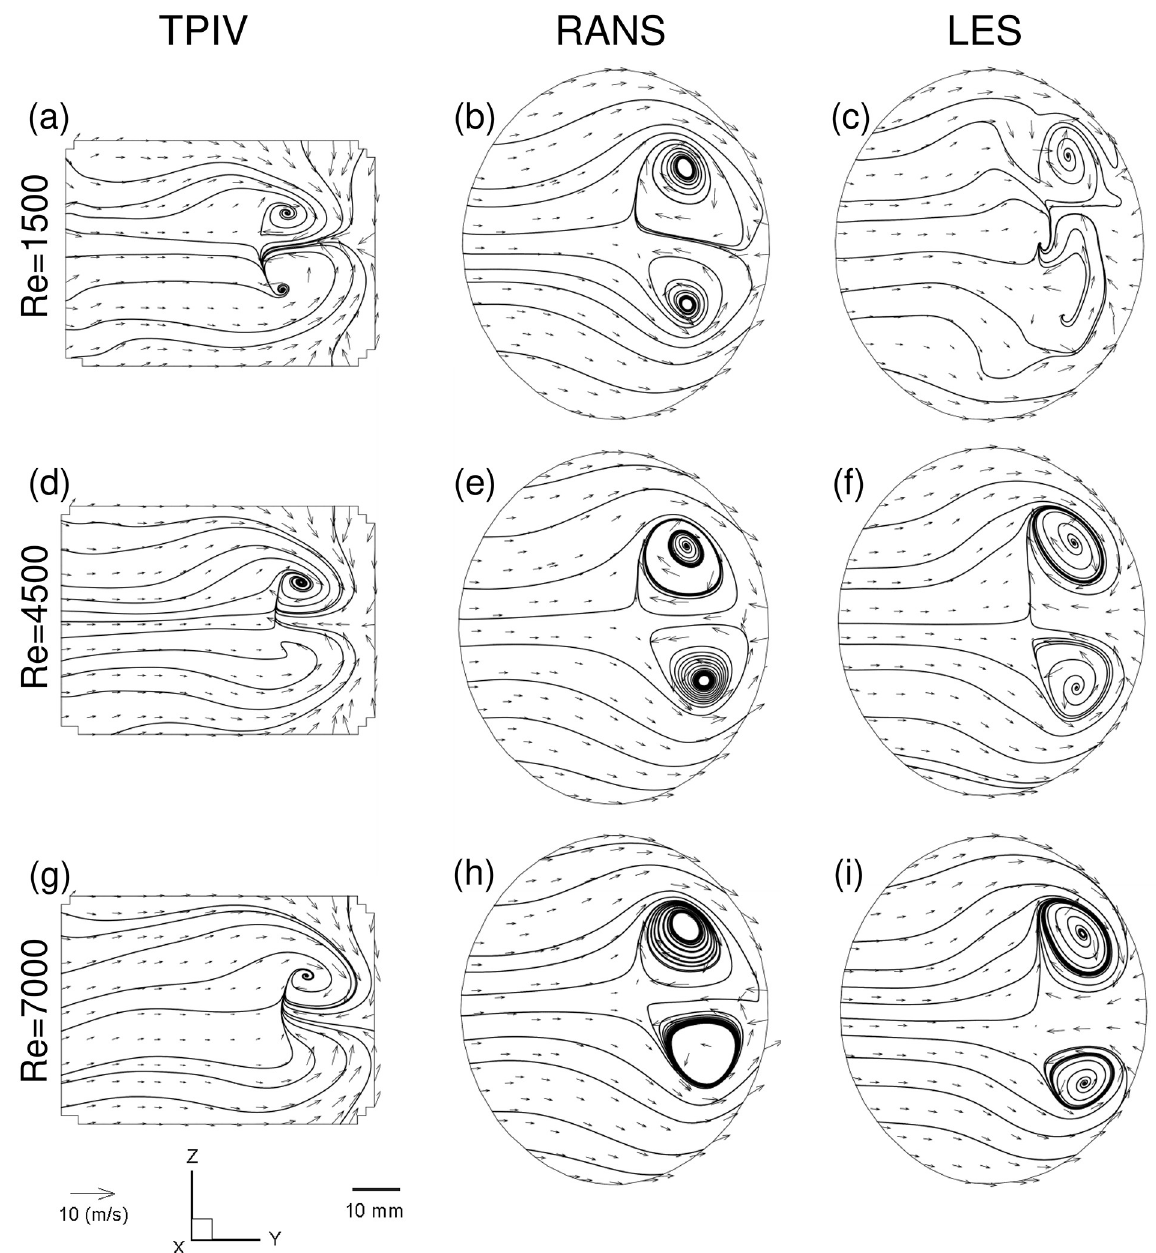
Fig 5. Flow characterization of the laryngeal jet with Reynolds variation on a transverse plane bisecting the jet’s wake. Results are presented as a function of the inlet Reynolds number for TPIV, RANS and LES, respectively and exemplifies reconstructed flow streamlines in the 2D cut plane (see Line C in Fig 6a for the location of the cut